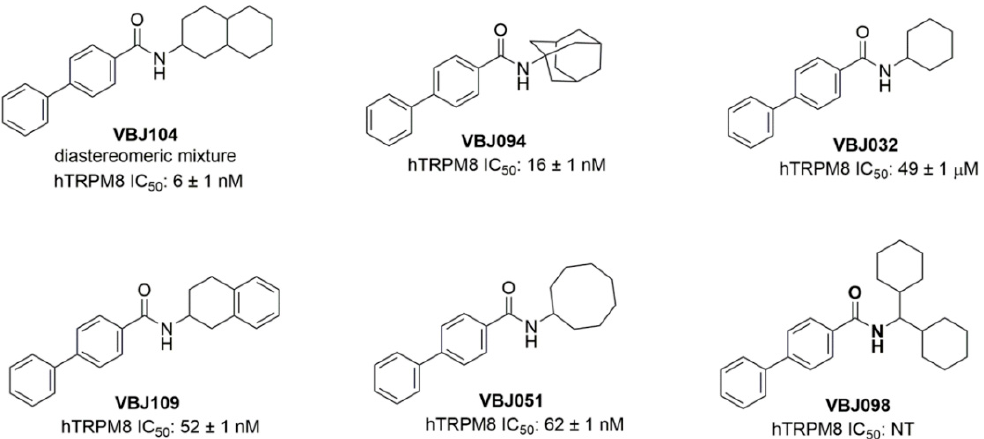
Figure 1. Structures of novel VBJ series compounds. The IC 50 values of hTRPM8 are from a previ- ously published report [25].